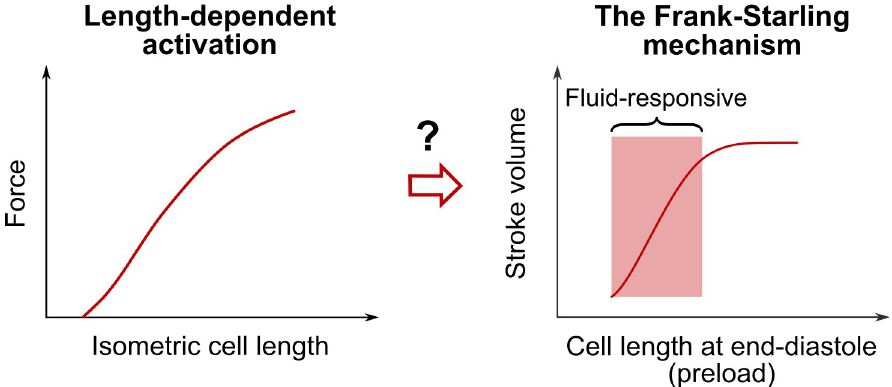
Fig 1. Length-dependent activation, the Frank-Starling mechanism and vascular filling therapy. Length-dependent activation (LDA) is a cardiac cell property highlighted by the length-tension relationship (left). As the length of the cardiac cell increases, the peak force during an isometric twitch contraction increases. It is commonly admitted that LDA underlies the Frank-Starling (FS) mechanism, a property of the cardiac pump (right). As the length of cardiac fibers prior to contraction (namely, the preload) increases, the ejected blood volume (namely, the stroke volume) increases, up to physiological limits. The FS mechanism is also often assumed to be the basis for fluid therapy. If the patient is operating on the “ascending portion” of the FS curve, the patient is said to be “fluid-responsive”, as a substantial stroke volume increase should be observed upon vascular filling. In this study, we revisit the three concepts of LDA, FS mechanism, and vascular filling and we build a computational model of the human cardiovascular system to investigate thoroughly the true nature of the relationship between the latter.